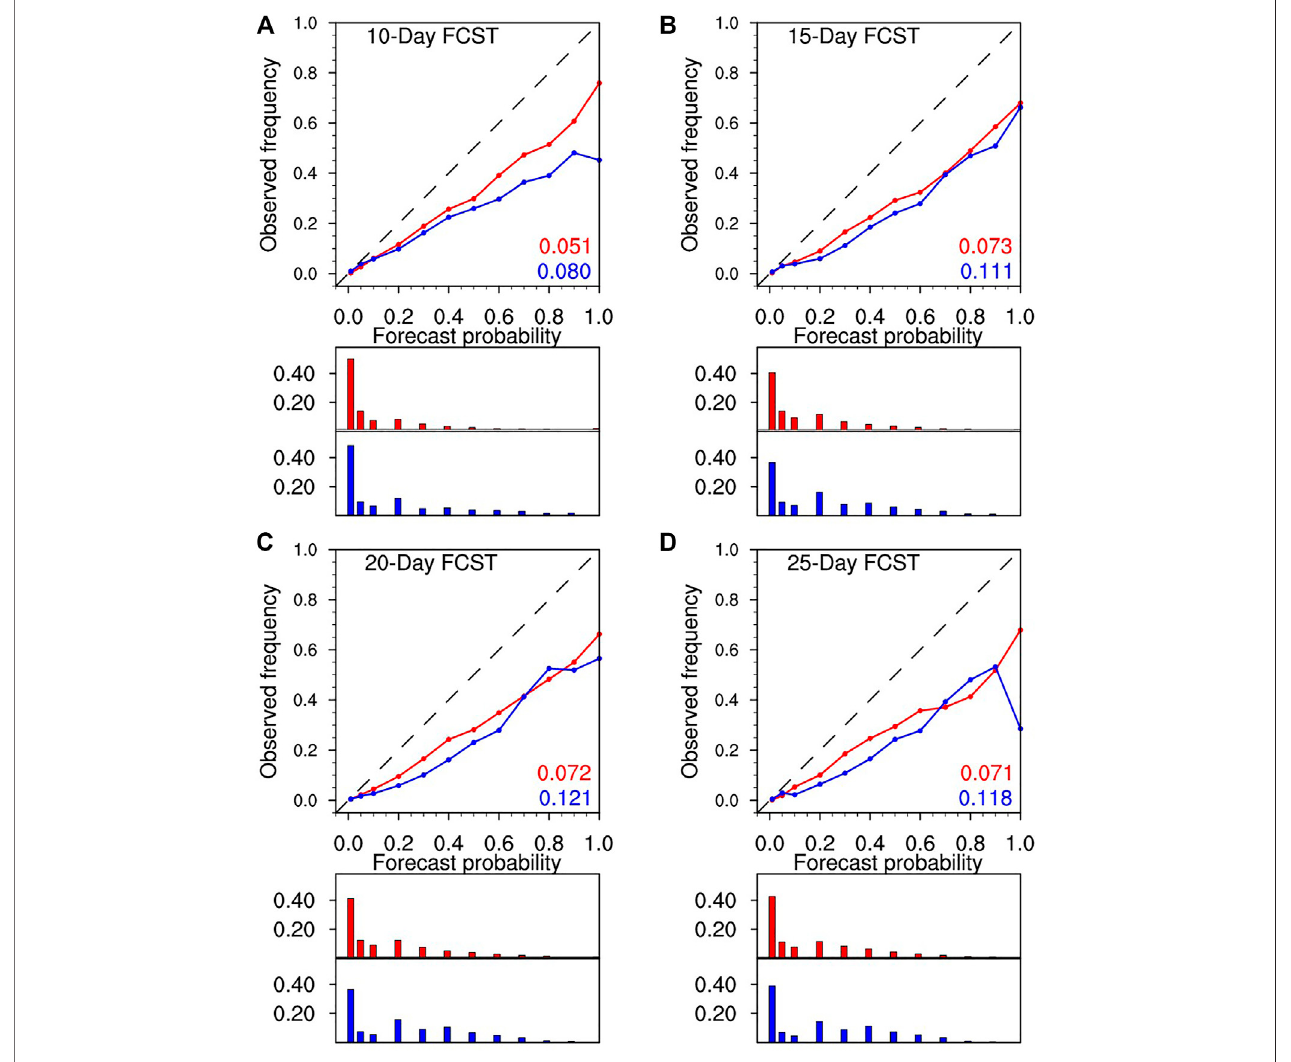
FIGURE 11 | The reliability diagram for heatwave for MME (blue) and BMA (red) at lead days 10 (A) , 15 (B) , 20 (C) , 30 (D) respectively. The forecast frequency in each probability bin is represented below on the bar plots for each forecast with the same color. The number inside each fi gure is the reliability which is the integral area from the diagonal line to forecast reliability line with weighting from the sample